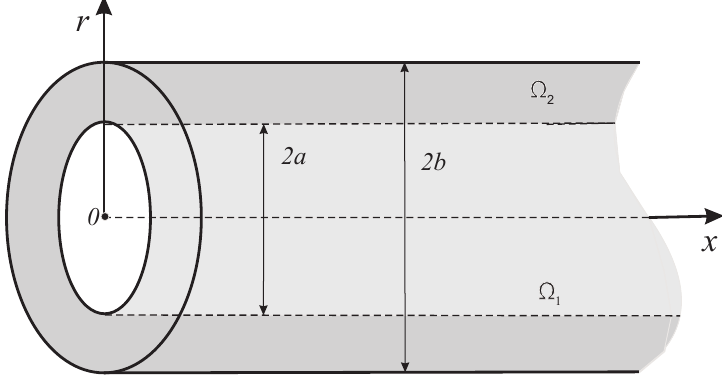
Figure 1. Cylindrical medium with cylindrical